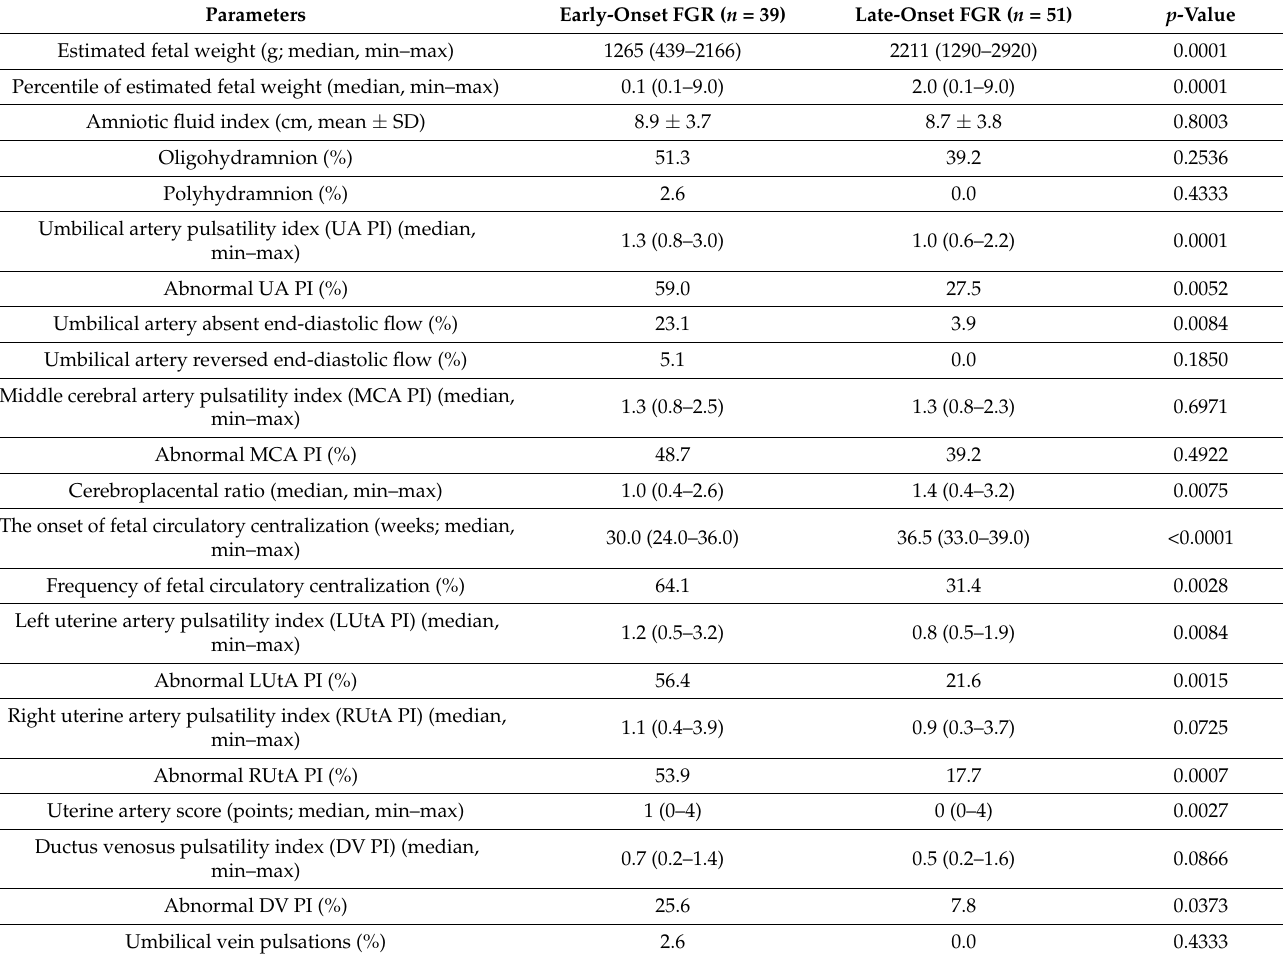
Table 2. Ultrasound findings in pregnancy complicated by the early-onset and late-onset